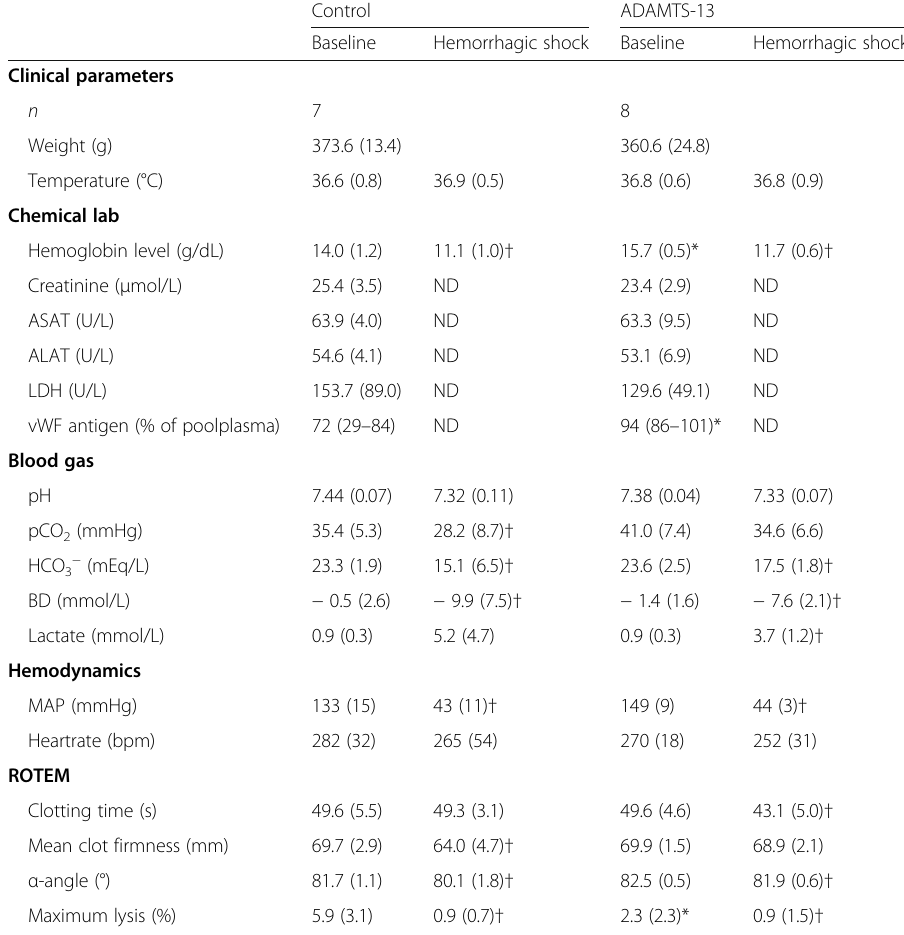
Values are presented as mean and standard deviation (SD) or median and interquartile range (IQR) BD base deficit, MAP mean arterial pressure, ND not done, NA not applicable *Significantly different from control, p < 0.05 † Significantly different from baseline, p <